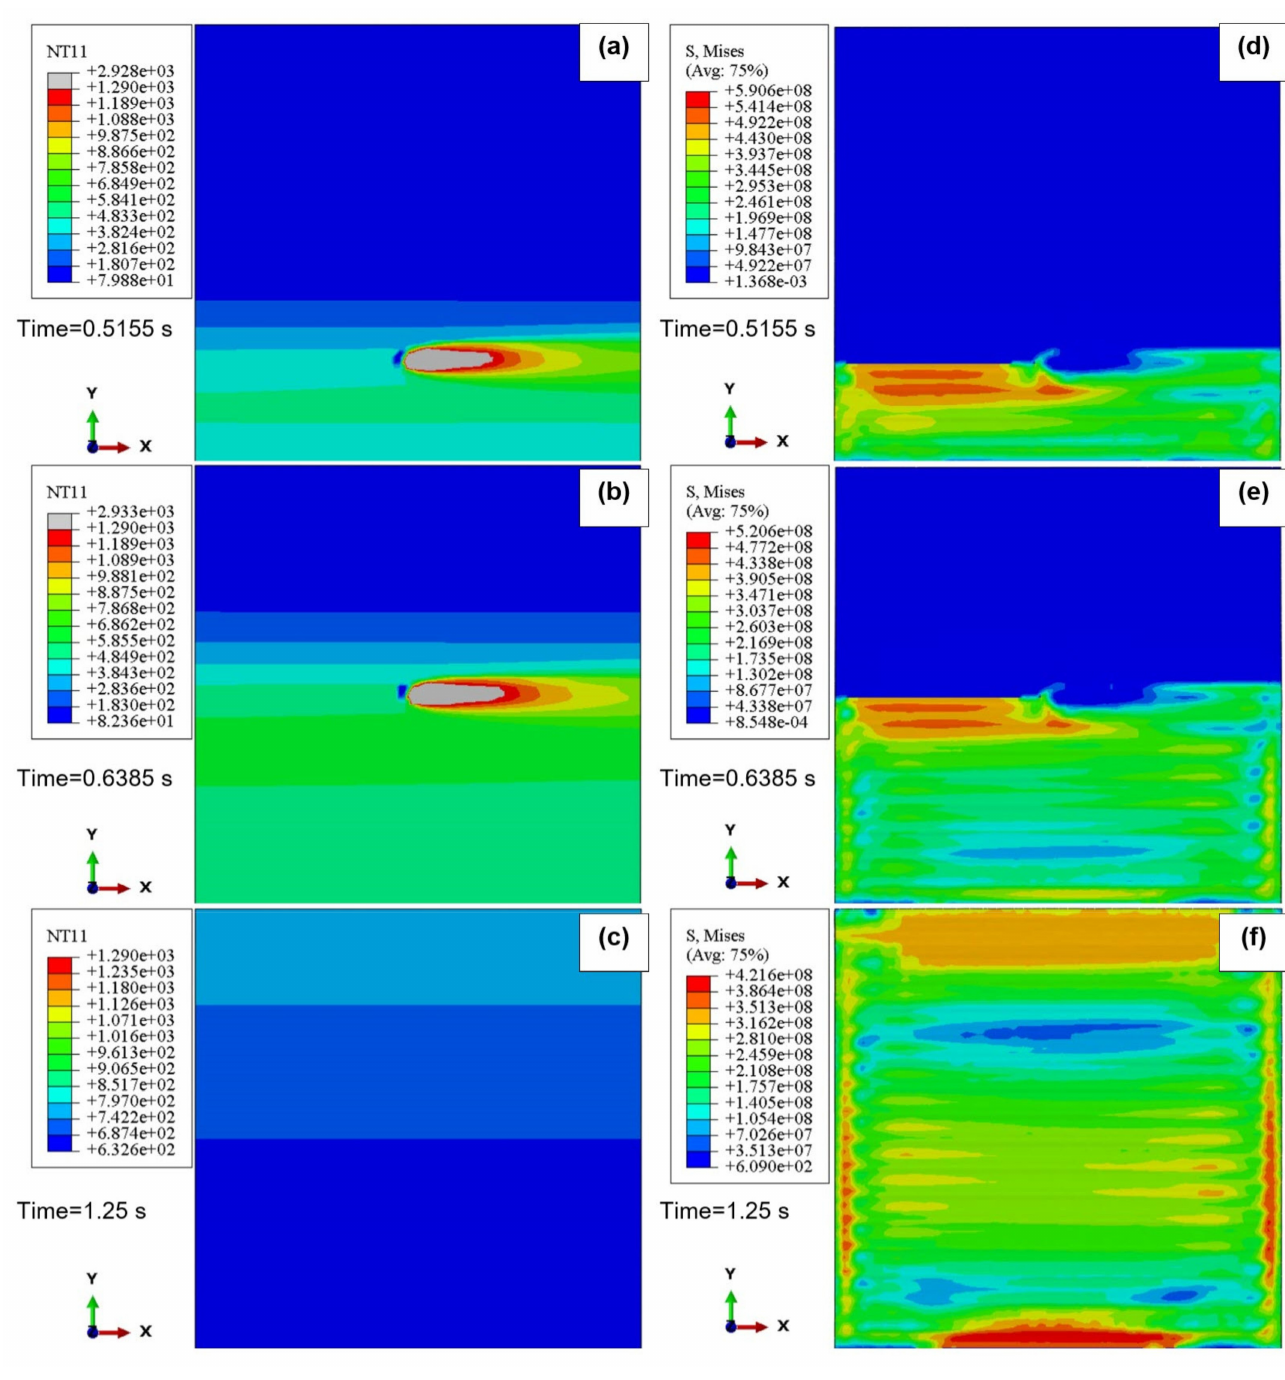
Figure 17. Temperature contours evolution ( a – c ) and Mises stress evolution ( d – f ) at different time